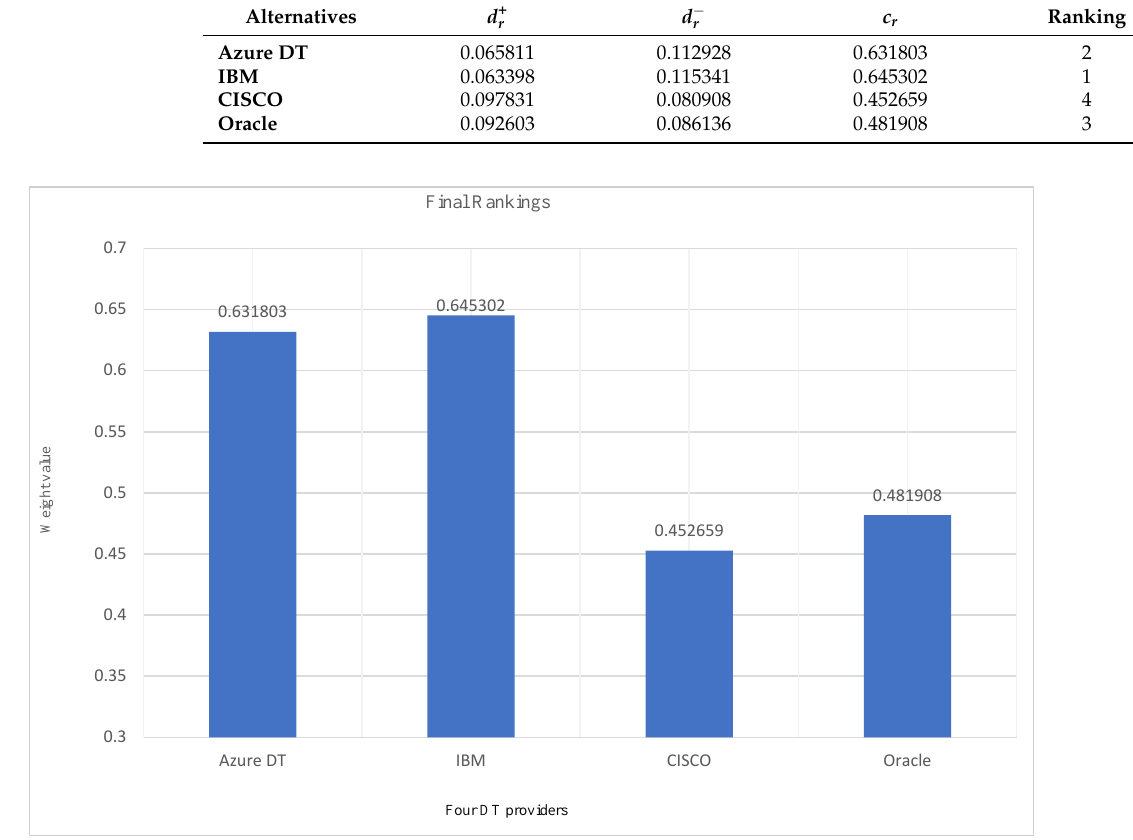
Table 9. The final ranking of alternatives according to relative closeness.